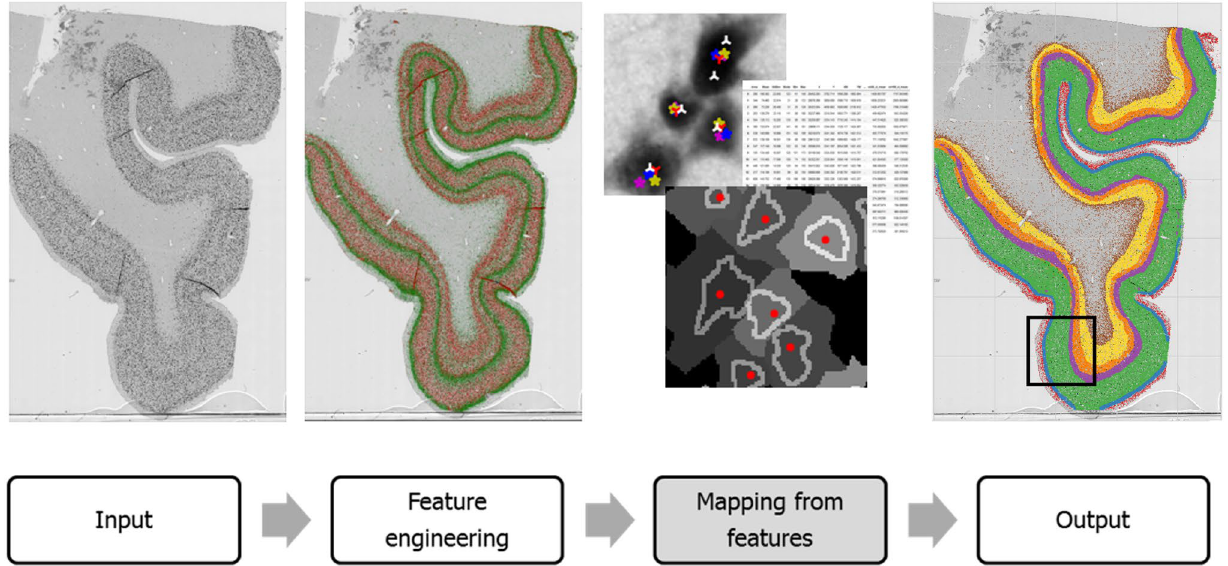
Figure 6. Learning to map neuronal phenotype to cortical layers using a classical machine learning pipeline. The neuron representation, or phenotyping, is based on automatic neuron segmentation and analysis of morphological and textural features. This representation is then used as an input to a machine learning model which learned to solve the multiclass classification task by classifying neurons among the six layers of the cortex. The model learned the variations in neuronal features and was able to generalize, i.e. create consistent and sensible predictions of layers across the whole histological section. The black rectangle frames the portion of the section that was manually labeled by three experts and used as training